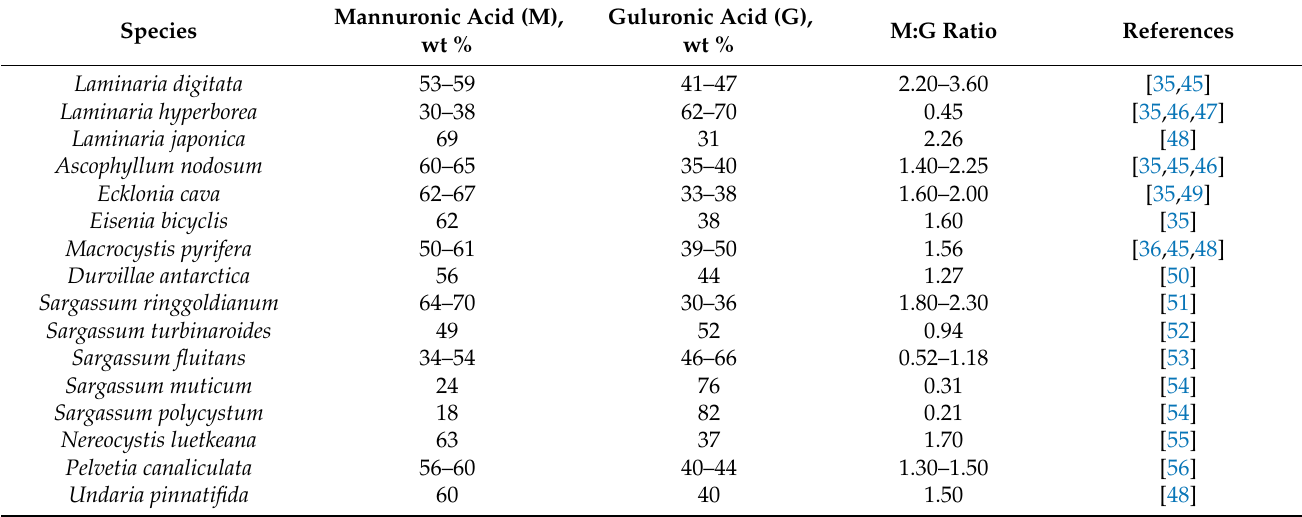
Table 2. Alginate composition of selected brown algae species.